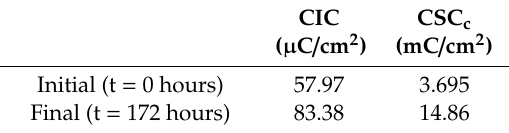
Table 6. Results at the beginning and end of the continuous pulse test for the cu ff electrode G.